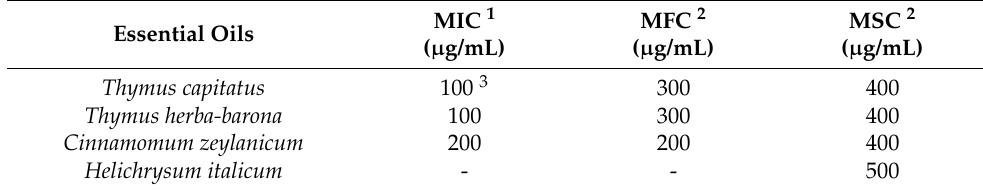
Table 2. Minimum inhibitory concentration (MIC), minimum fungicidal concentration (MFC) and minimum sporicidal concentration (MSC) values of the four pure essential oils that showed the highest activity against Ascosphaera apis in the preliminary agar diffusion tests.